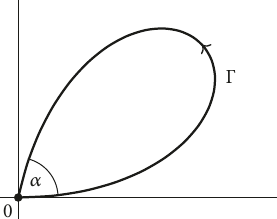
Figure 2: Winding number with respect to the origin sitting on the curve Γ